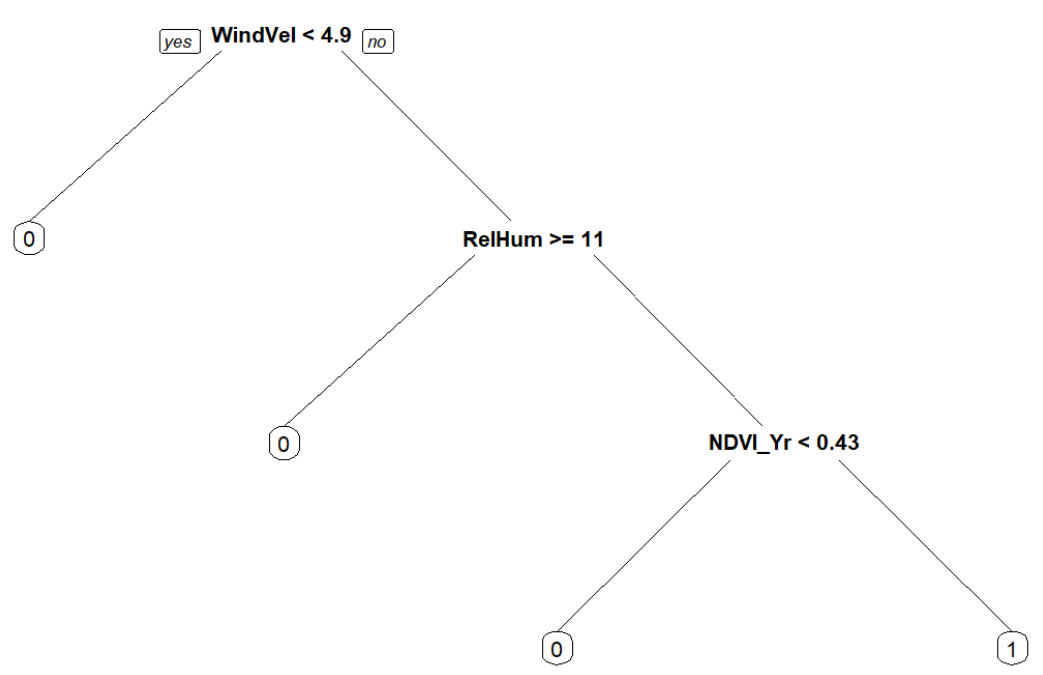
Figure 7. Classification tree explaining the factors differentiating destructive (1) and non-destructive (0) wildfires ≥ 100 ha from 2000 – 2018 in Southern